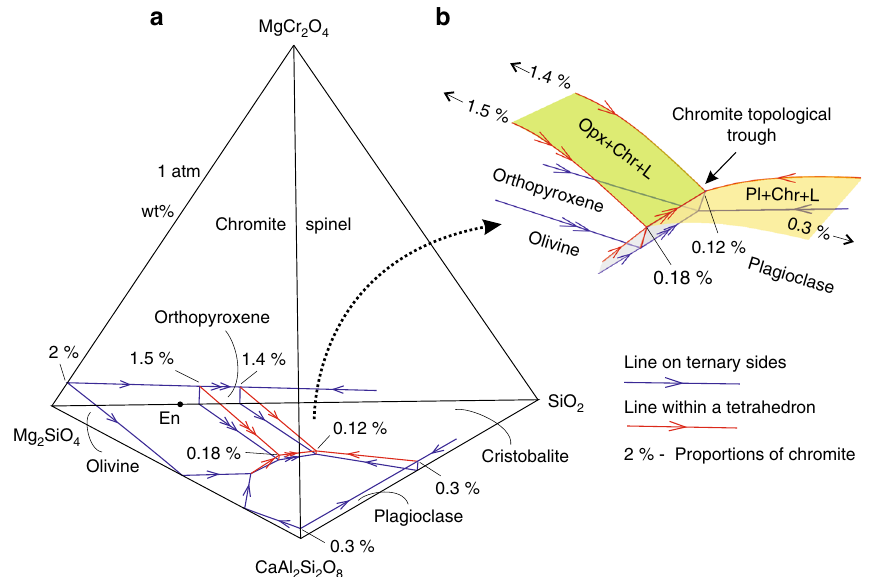
Fig. 2 The chromite topological trough in basaltic systems. a Phase relations in a quaternary system Mg 2 SiO 4 – CaAl 2 Si 2 O 8 – SiO 2 – MgCr 2 O 4 at 1 atm. The stability volume of chromite, represented by a complete solid solution series between MgAl 2 O 4 -spinel and MgCr 2 O 4 -spinel, occupies almost the entire interior of the diagram. It is continuous between the top apex of the tetrahedron and the small triangular liquidus fi eld of MgAl 2 O 4 -spinel on the basal ternary diagram Mg 2 SiO 4 – CaAl 2 Si 2 O 8 – SiO 2 . b A close-up of the diagram showing the chromite topological trough between stability volumes of orthopyroxene/olivine and plagioclase. The trough plays a decisive role in the generation of basaltic melts saturated in chromite alone (Fig. 3). The fi gure is modi fi ed from ref. 13 , with the topology being slightly distorted for illustration purposes. Here and in all subsequent fi gures, cotectic and reaction lines are indicated by one or two arrows, respectively. Here and in all subsequent fi gures and text: An, anorthite; Fo, forsterite; Opx, orthopyroxene; Ol, olivine; Pl, plagioclase; Cpx, clinopyroxene; Chr, Cr-spinel; Qtz, quartz; Grt, garnet